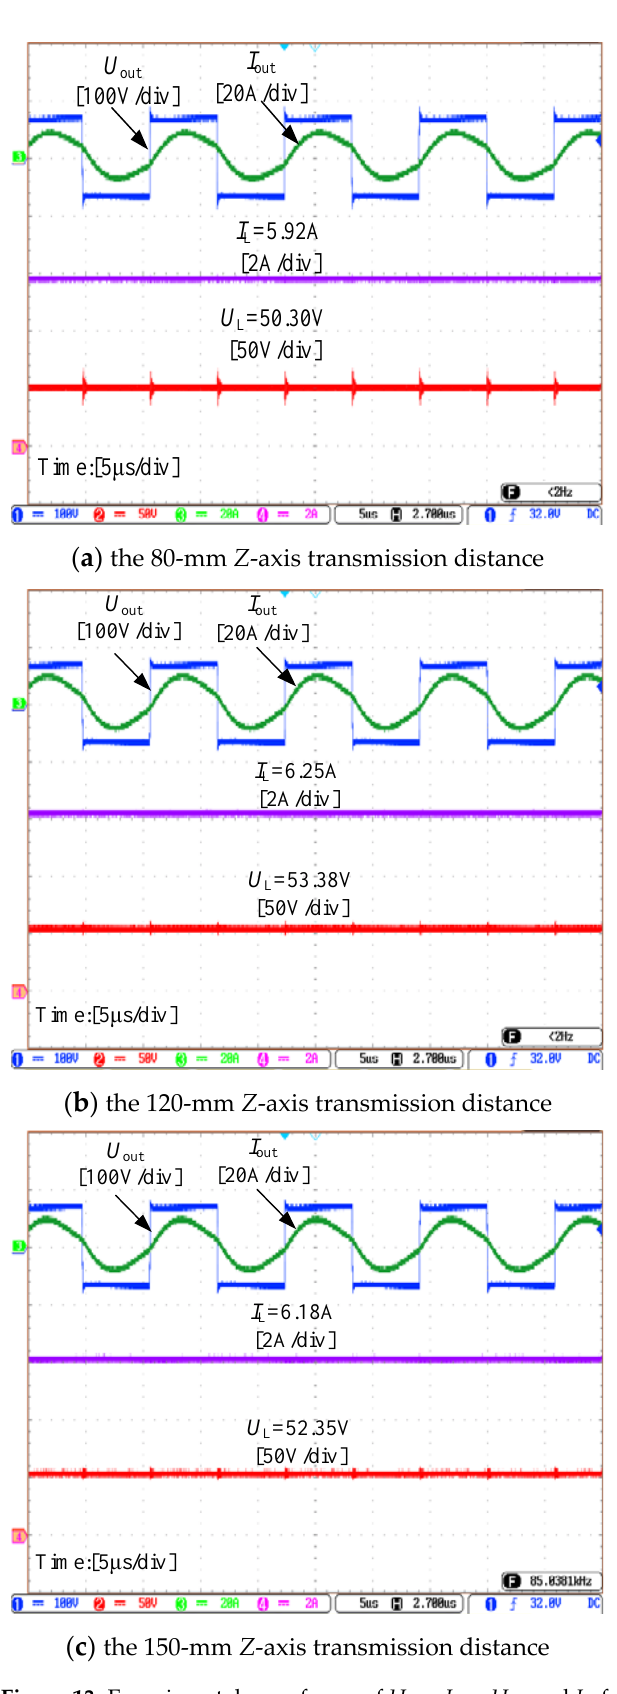
Figure 13. Experimental waveforms of U out , I out , U L , and I L for half load with R L = 8.5 Ω .